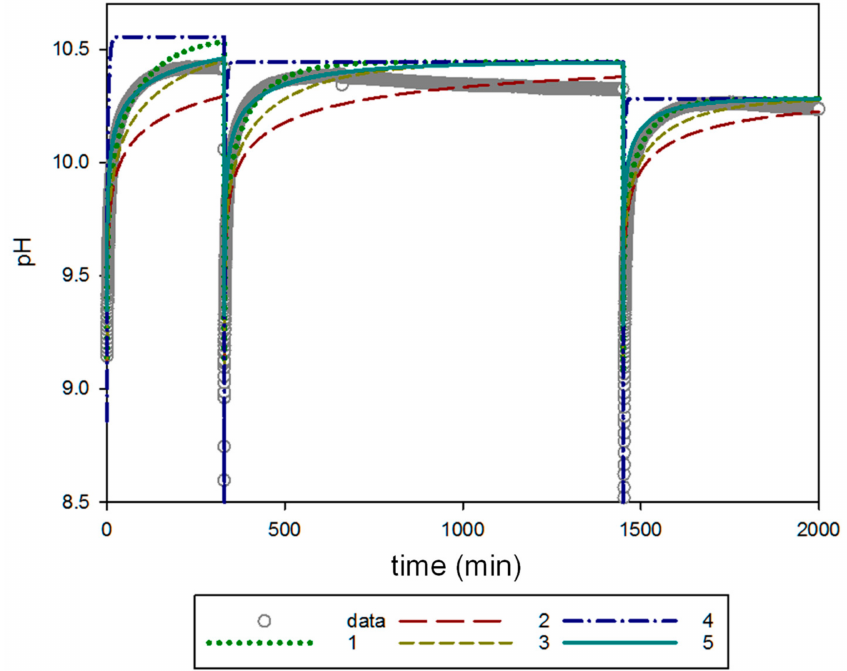
Figure 6. Simulations conducted to explore the possible influence of particles not encapsulated within the oil droplets of an emulsion containing 0.1% wt. MgO. Measured pH is shown as the grey open circles. Note that the temporal resolution of discrete pH measurements gave the illusion of a line. The lumped mass transfer coefficient, k L , was fit to a series of hypothetical fractions of unencapsulated particles, f ,fast . Simulations: (1—dashed line) f ,fast = 0.05 produced a best fit k L of 6.1 × 10 − 5 min − 1 ; (2—medium dashed line) f ,fast = 0.00025 produced a best fit k L of k L = 6.0 × 10 − 5 min − 1 ; (3—short dashed line) f ,fast = 0.025 produced a best fit k L of 6.0 × 10 − 5 min − 1 ; (4—dot and dashed line) f ,fast = 0.99 produced a best fit k L of 6.0 × 10 − 6 min − 1 ; and (5—solid line) f ,fast = 0 produced a best fit k L of 2.7 × 10 − 4 min − 1 and. All models were run with k diss = 1.2 × 10 − 3 min − 1 and K sp,MgO = 5.01 × 10 − 11